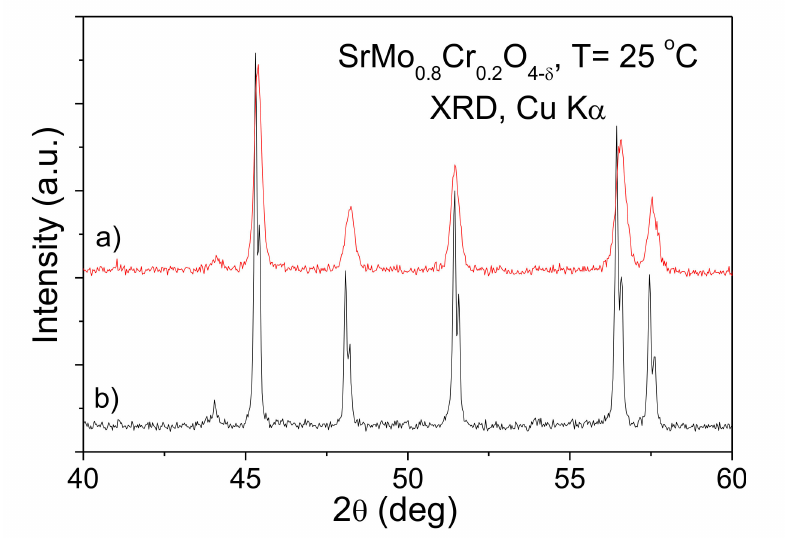
Figure 1. XRD patterns for SrMo 0.8 Cr 0.2 O 4 − δ ( a ) by direct treatment in air of the citrate precursors, ( b ) by reoxidizing topotactically at 500 ◦ C in air, of the reduced